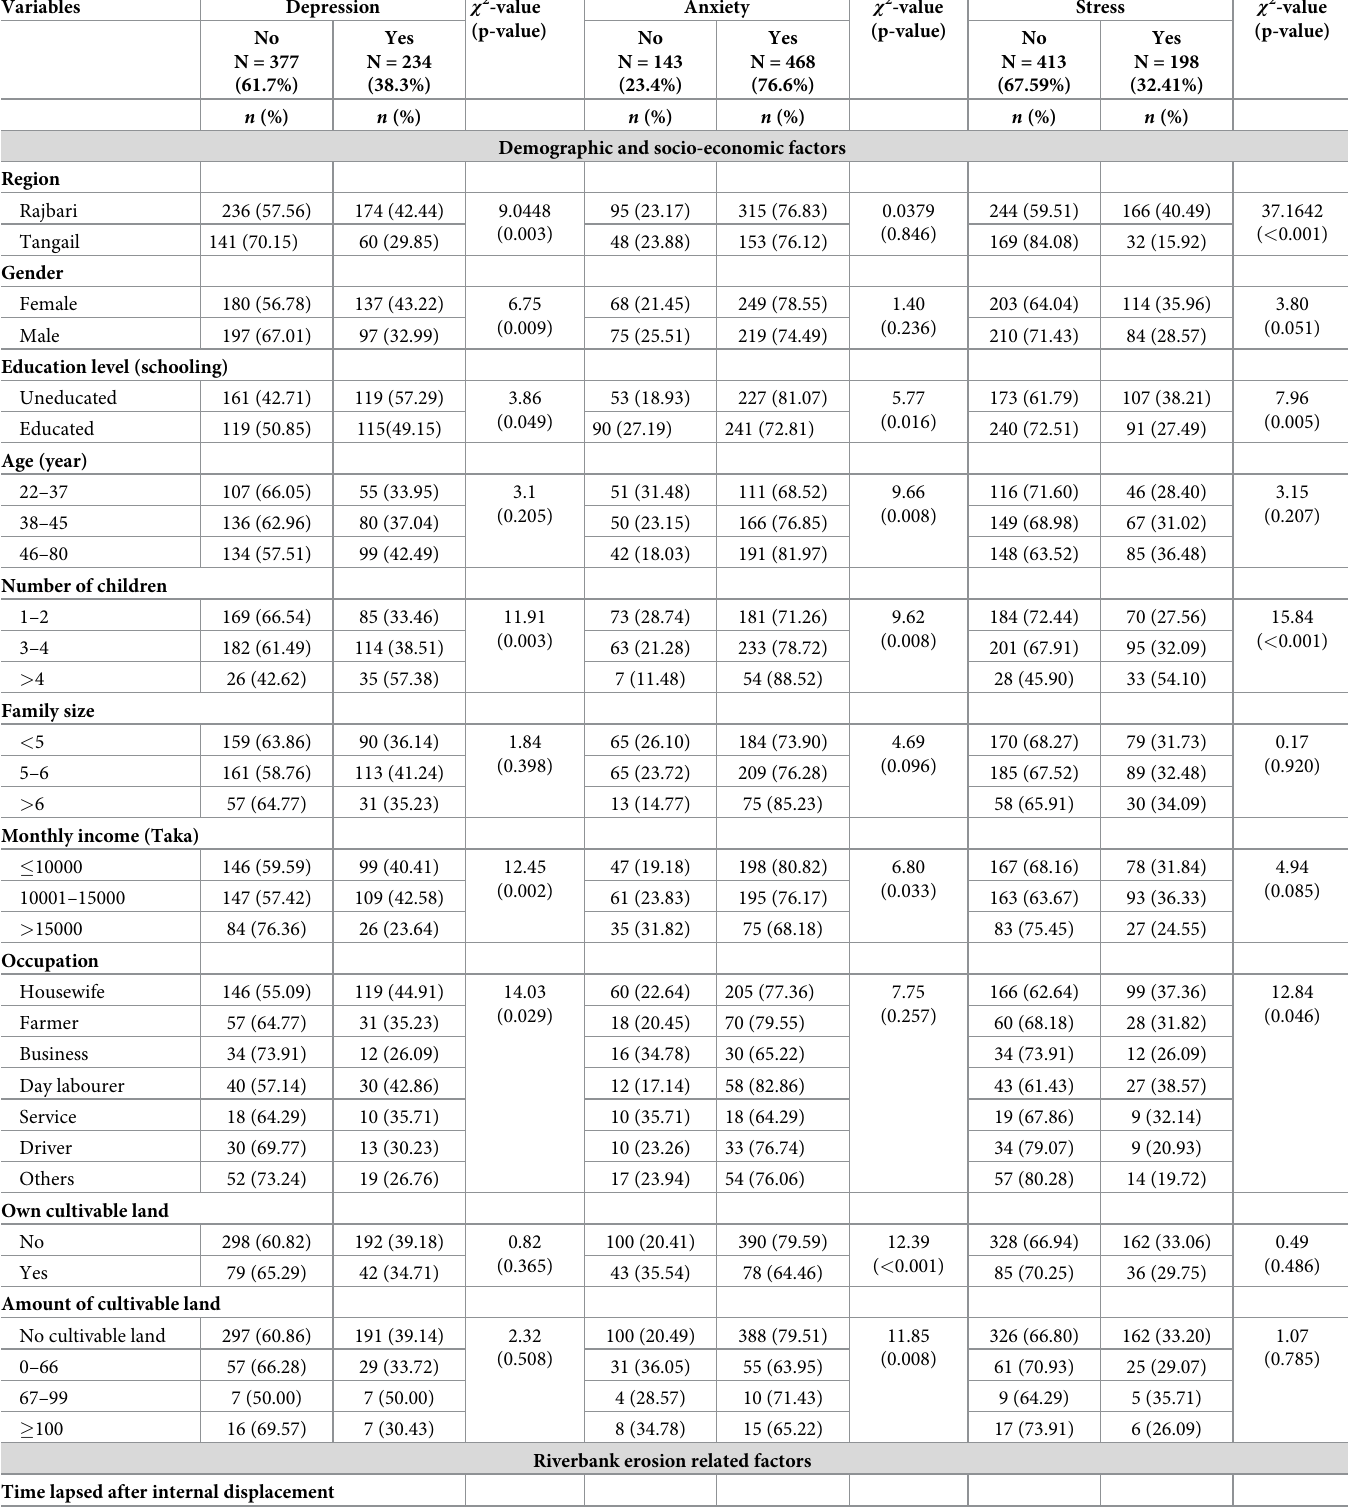
Table 2. The bivariate distribution of depression, anxiety and stress with different risk